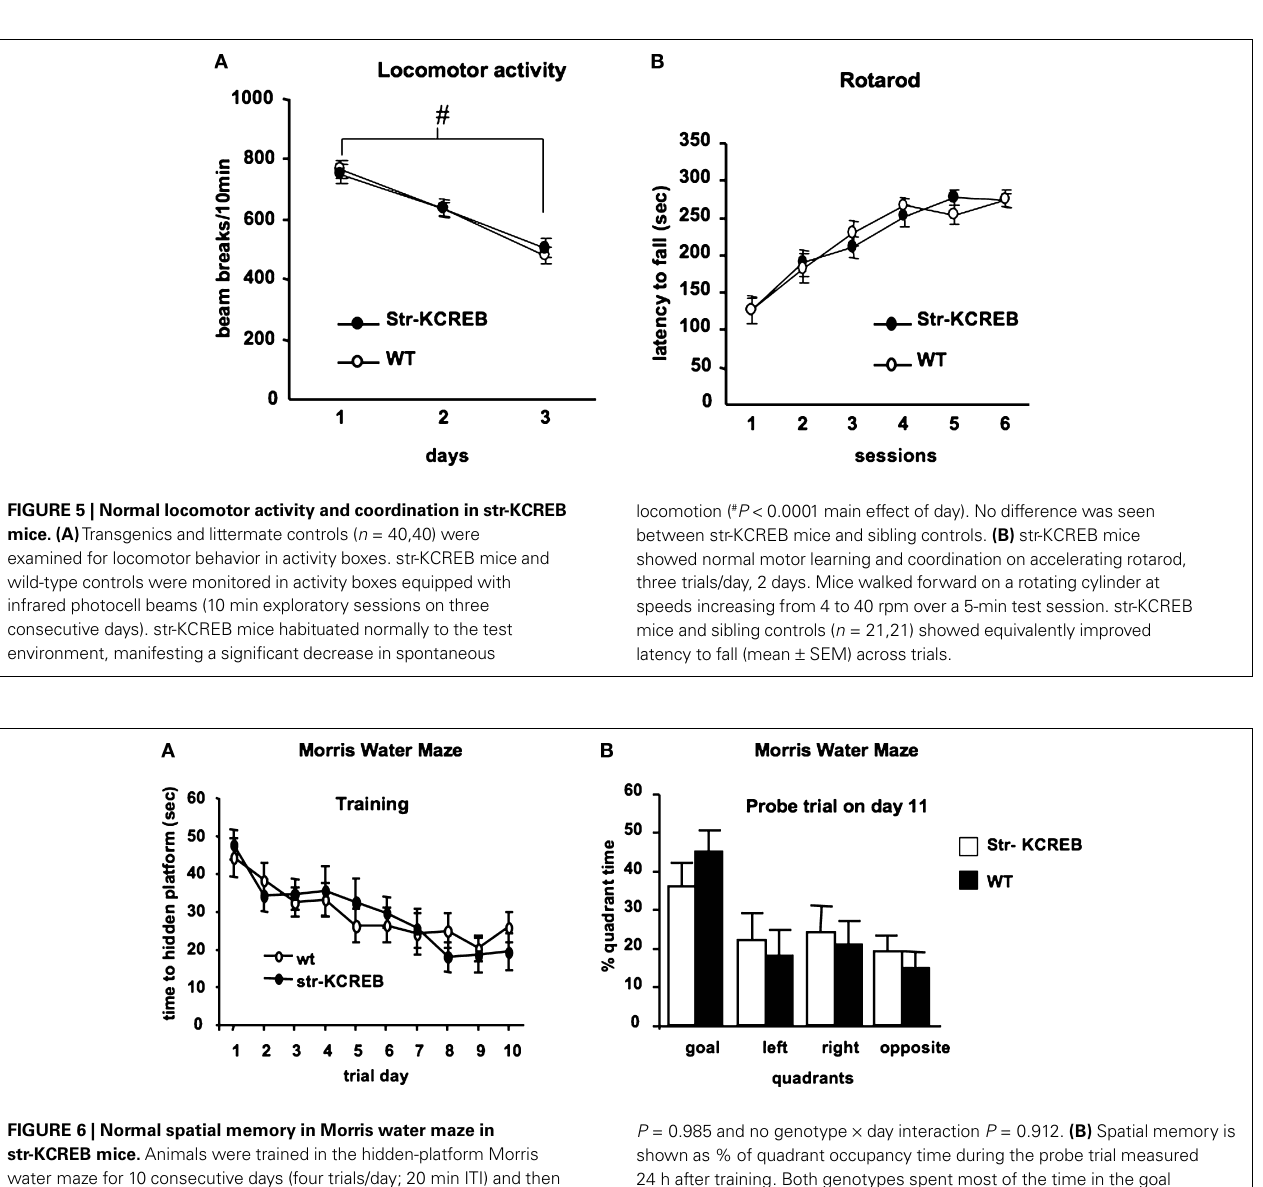
P = 0.985 and no genotype × day interaction P = 0.912. (B) Spatial memory is shown as % of quadrant occupancy time during the probe trial measured 24 h after training. Both genotypes spent most of the time in the goal quadrant (ANOVA repeated measures, spatial effect, P < 0.01), with no signifi cant differences between genotypes ( n = 10,10), group effect on goal occupancy, P > 0.1.